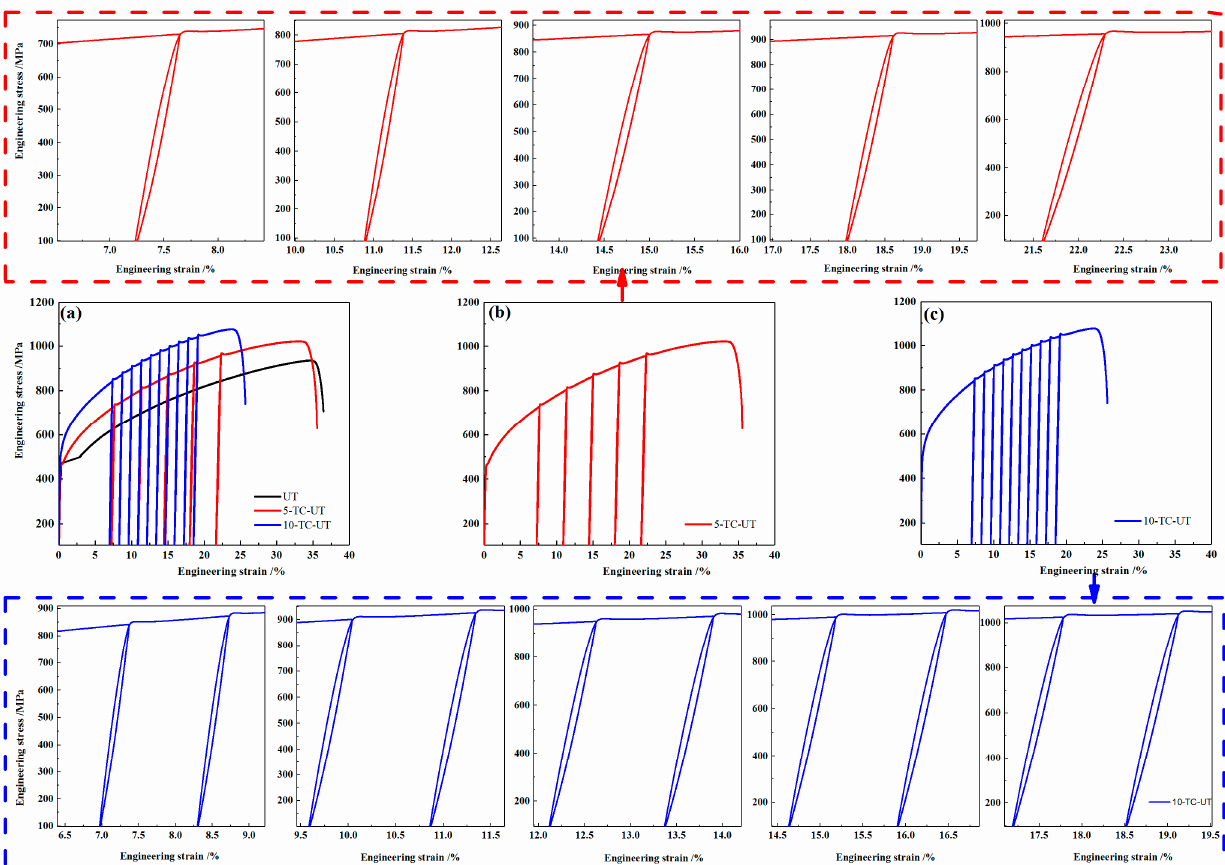
Figure 4. ( a ) Engineering stress–strain curves of the UT, 5-TC-UT, and 10-TC-UT specimens; ( b ) and ( c ) engineering stress–strain curves of the 5-TC-UT specimen with intermittent hysteresis loops for every 2% strain increment and 10-TC-UT specimens with intermittent hysteresis loops for every 4% increment. Each hysteresis loop is enlarged.